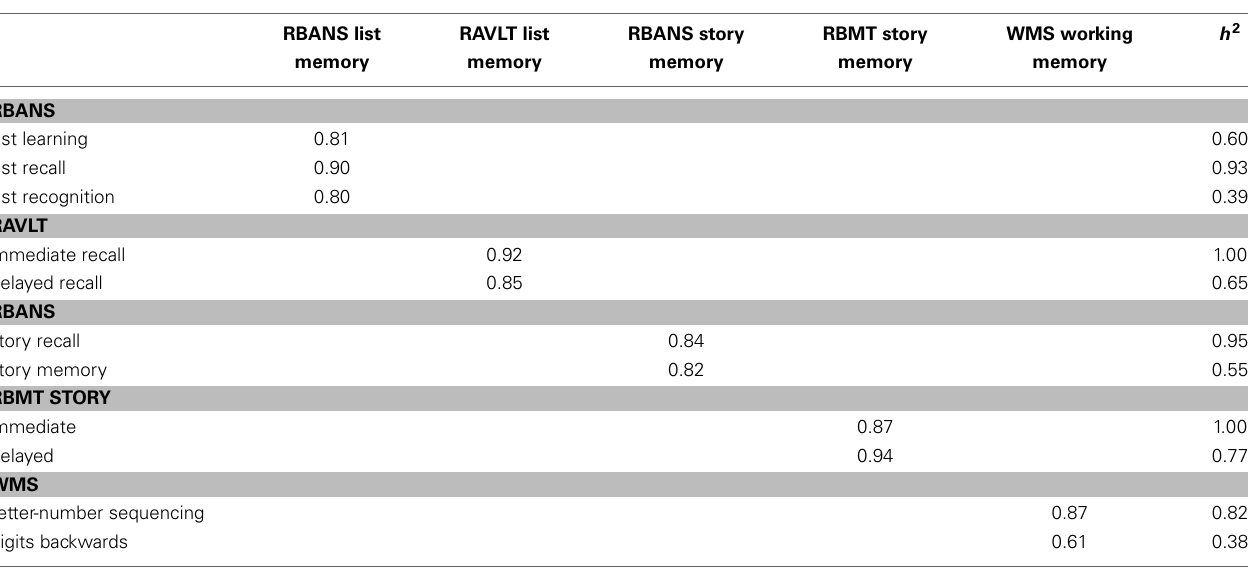
Table 3 | Standardized factor loadings of the structural invariance model for outcomes.